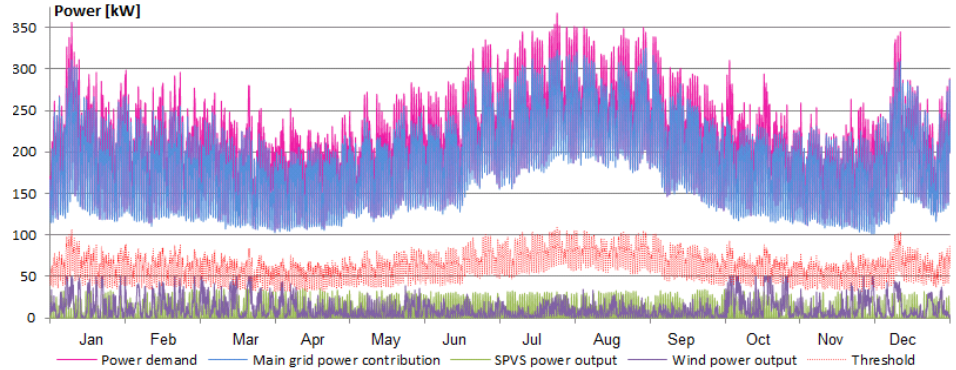
Figure 3. Power output from the various sources and demand. SPVS: solar photovoltaic